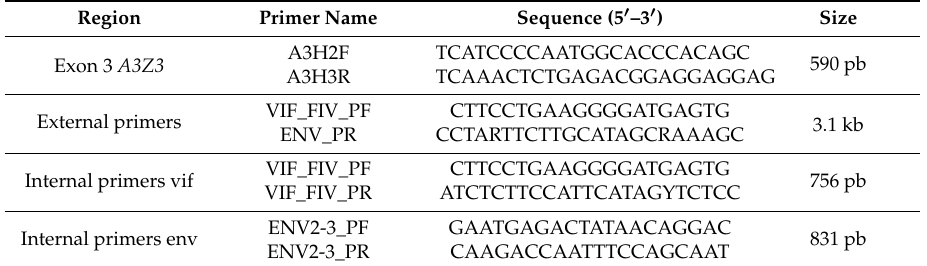
Table A1. Primers used in this study to amplify proviral genes ( env and vif ) from exon 3 of A3Z3 -positive FIV